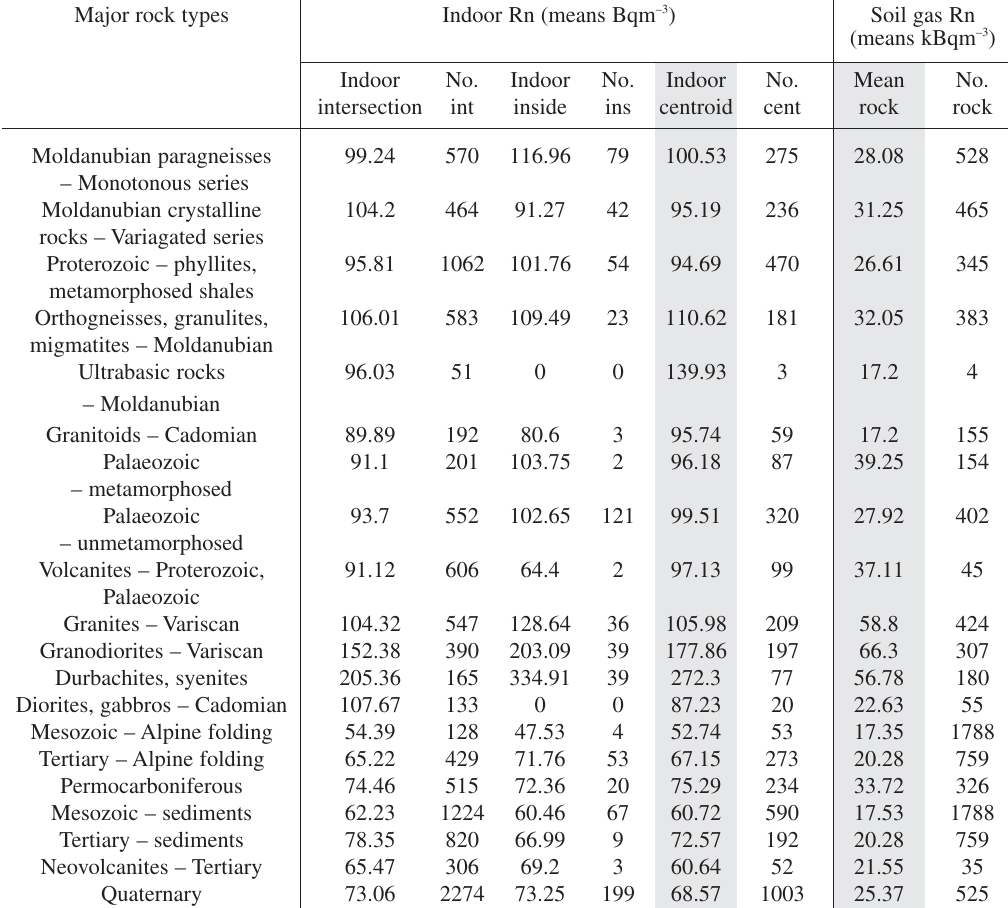
Table II. The values of indoor radon geometric means in major rock types calculated by three different